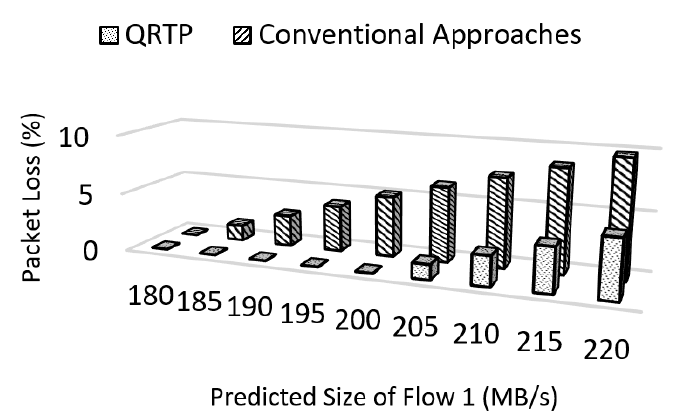
Figure 4. A sample four nodes topology.